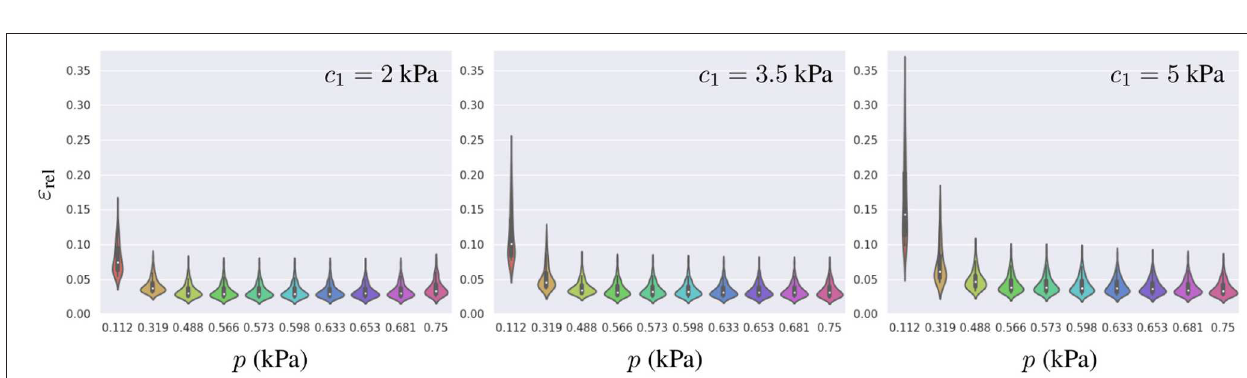
2, 3.5, and 5 kPa, and each model was loaded with 10 different =